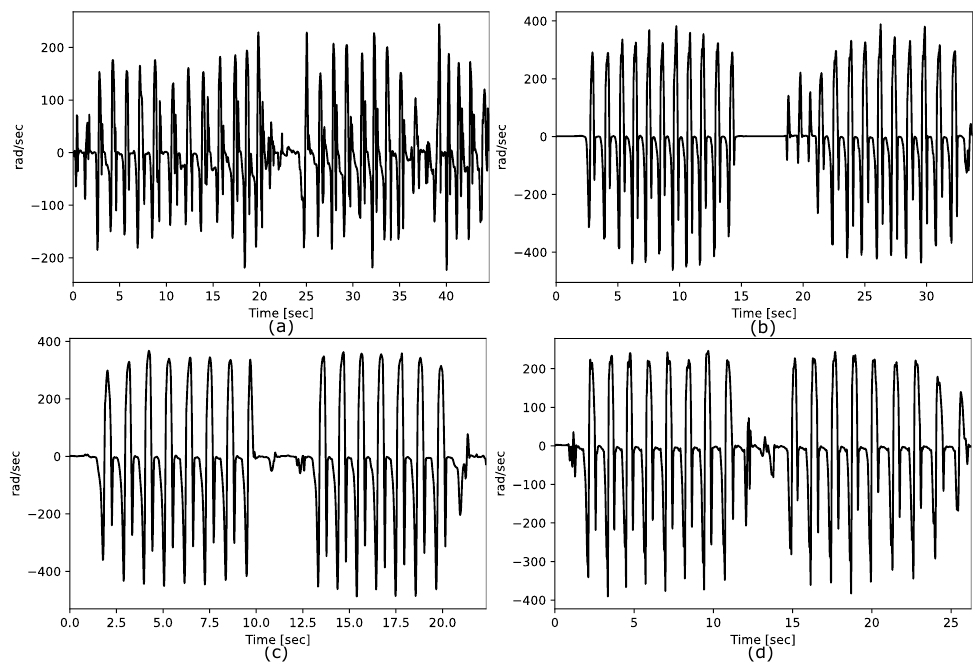
Figure 7. Comparison between the raw time series of: ( a ) PD female patient, Lower limps score: 50, Age: 75; ( b ) PD female patient, Lower limps score: 10, Age: 65; ( c ) EHC female patient, Age: 50; ( d ) YHC female patient, Age: